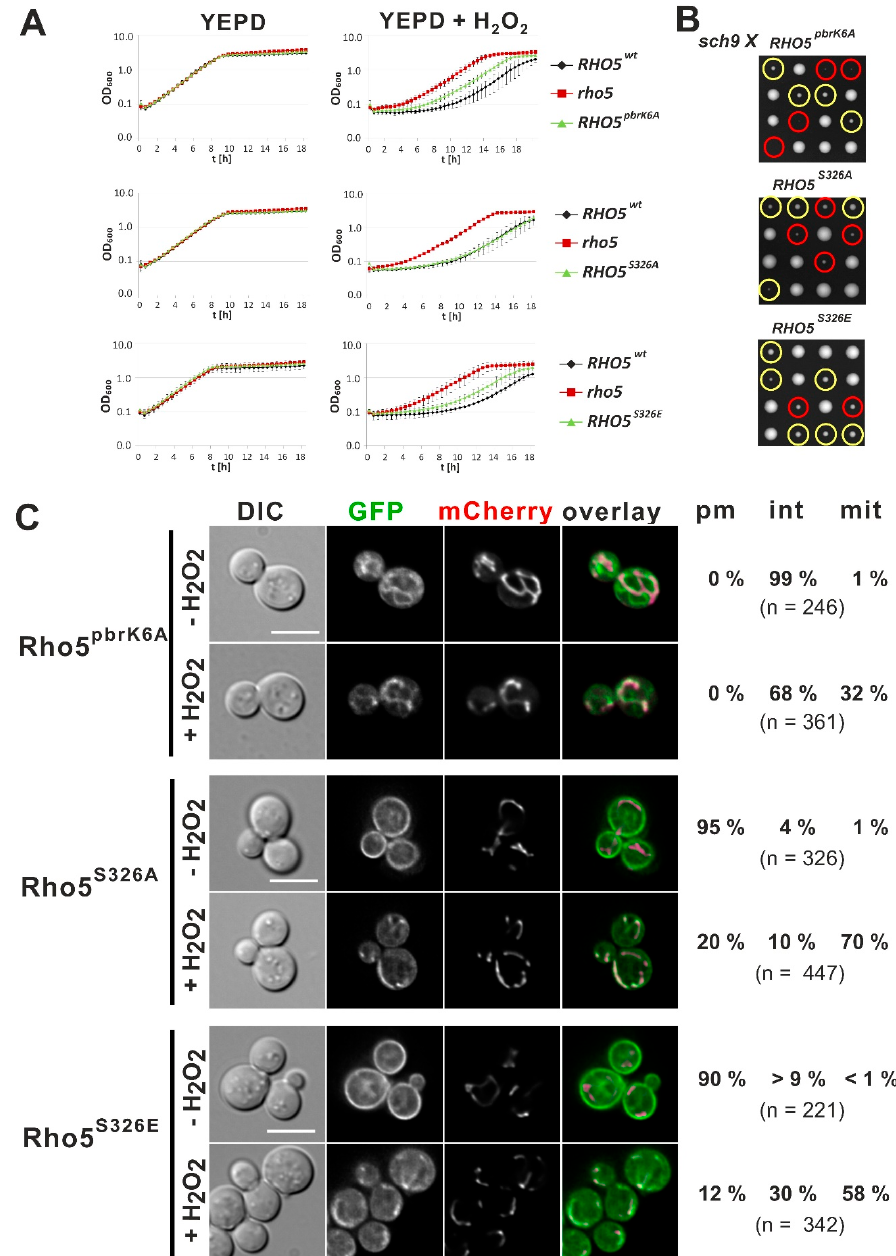
Figure 3. Growth and response to oxidative stress of mutants in the polybasic region of Rho5. ( A ) Growth curves were obtained in rich medium as described in materials and methods and the legend of Figure 2. ( B ) Tetrad analyses of crosses from strains carrying the indicated RHO5 allele to a sch9 deletion strain performed on YEPD. Parental strains employed in crosses to HOD348-4D ( sch9 ) were HOD337-7D ( RHO5 pbrK6A ), HD56-RH S326A ( RHO5 S326A ), and HD56-R7 ( RHO5 S326E ). Yellow and red circles indicate segregants with a RHO5 sch9 and a mutant RHO5 sch9 constitution, respectively. ( C ) Life-cell fluorescence microscopy of a rho5 deletion strain carrying IDP1-mCherry as a mitochondrial marker (HCSO76-1A) and the RHO5 alleles indicated as N-terminal GFP fusions introduced on a CEN / ARS vector. Plasmids employed were pCSO35 = GFP-Rho5 pbrK6A , pCSO19 = GFP-Rho5 S326A , pCSO31 = GFP-Rho5 S326E (Table 2). Growth conditions, scales, and determination of distribution numbers were as described in the legend of Figure